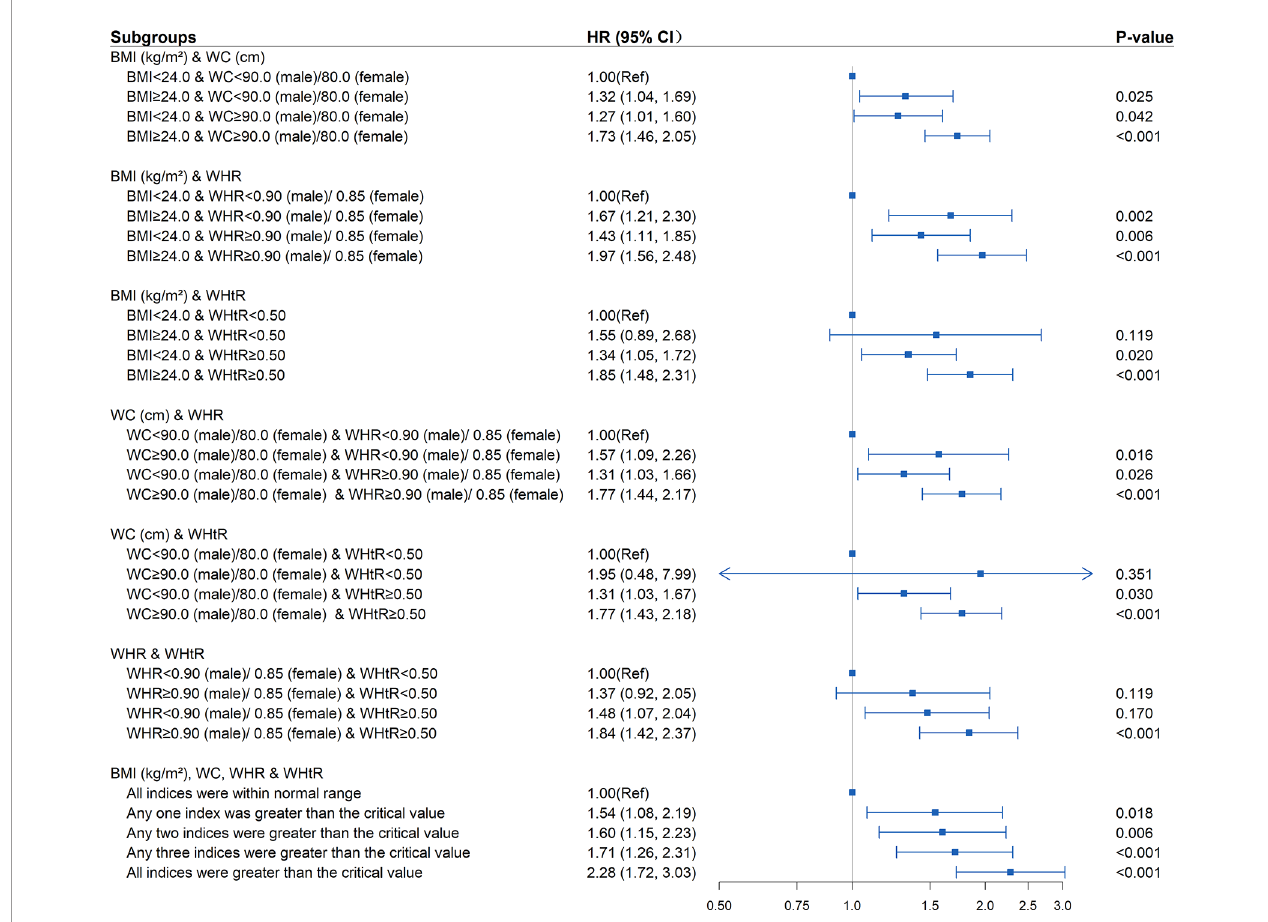
FIGURE 3 | Association between different combinations of body mass index (BMI) and established anthropometric indices of central obesity (waist circumference [WC], waist-to-hip ratio [WHR], waist-to-height ratio [WHtR]) with the development of diabetes. The correlation was assessed by multivariate cox regression analysis, adjusted by sex, age, smoking status, drinking status, and family history of diabetes at baseline and differences of FPG, TG, TC, HDL, LDL, SBP, DBP between the baseline and follow-up. Hazard ratios (HRs) of the combined anthropometric indices were represented as the squares and 95% con fi dence intervals (CIs) by the lines through the